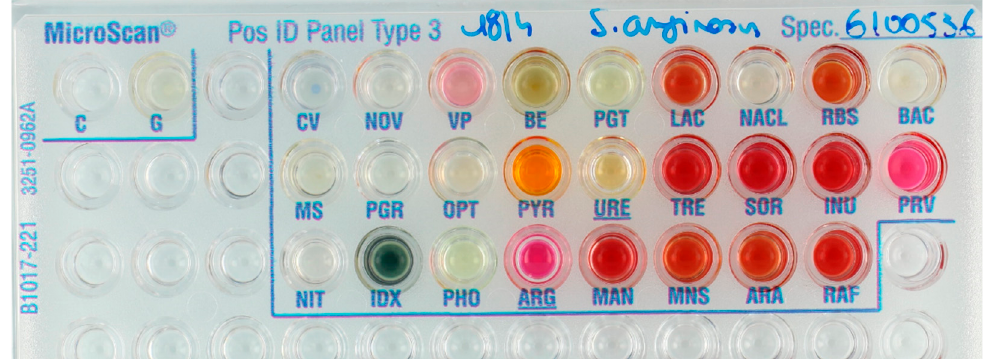
Figure 4. Streptococcus anginosus reference isolate incorrectly identified as S. mitis/oralis. Note that both PHO and PGT wells were considered positive when this panel was read; “any shade of yellow” leads to a positive result according to the instructions for use (IFU). A negative reading would have resulted in the correct identification of S. anginosus . Note also that Voges–Proskauer (VP) test was judged negative because “pale pink” is to be considered negative according to the IFU. A positive result of VP would have led to an identification of S. parasanguinis .